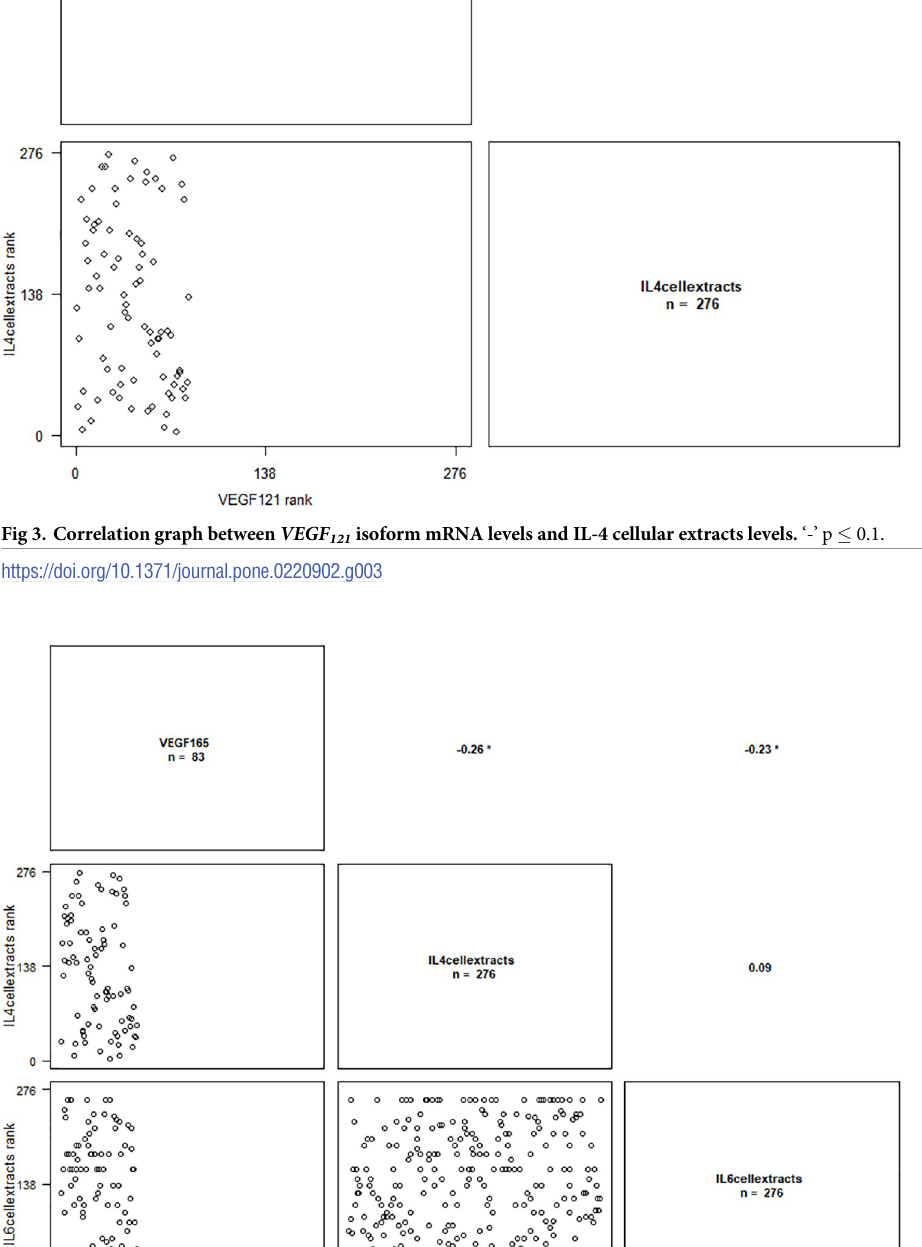
isoform mRNA levels and IL-4 and IL-6 cellular extracts levels. ‘ � ’ 165